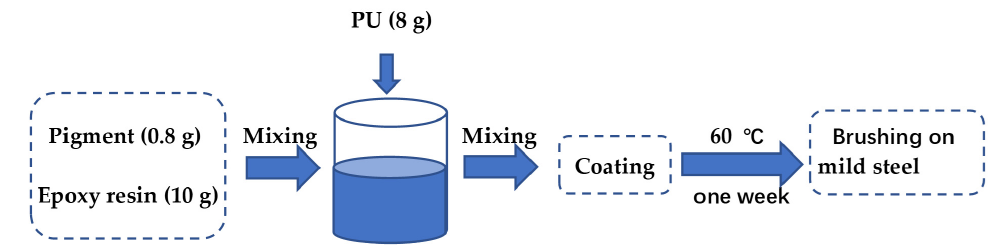
Figure 1. Schematic diagram of the preparation process of the anti-corrosive coating.